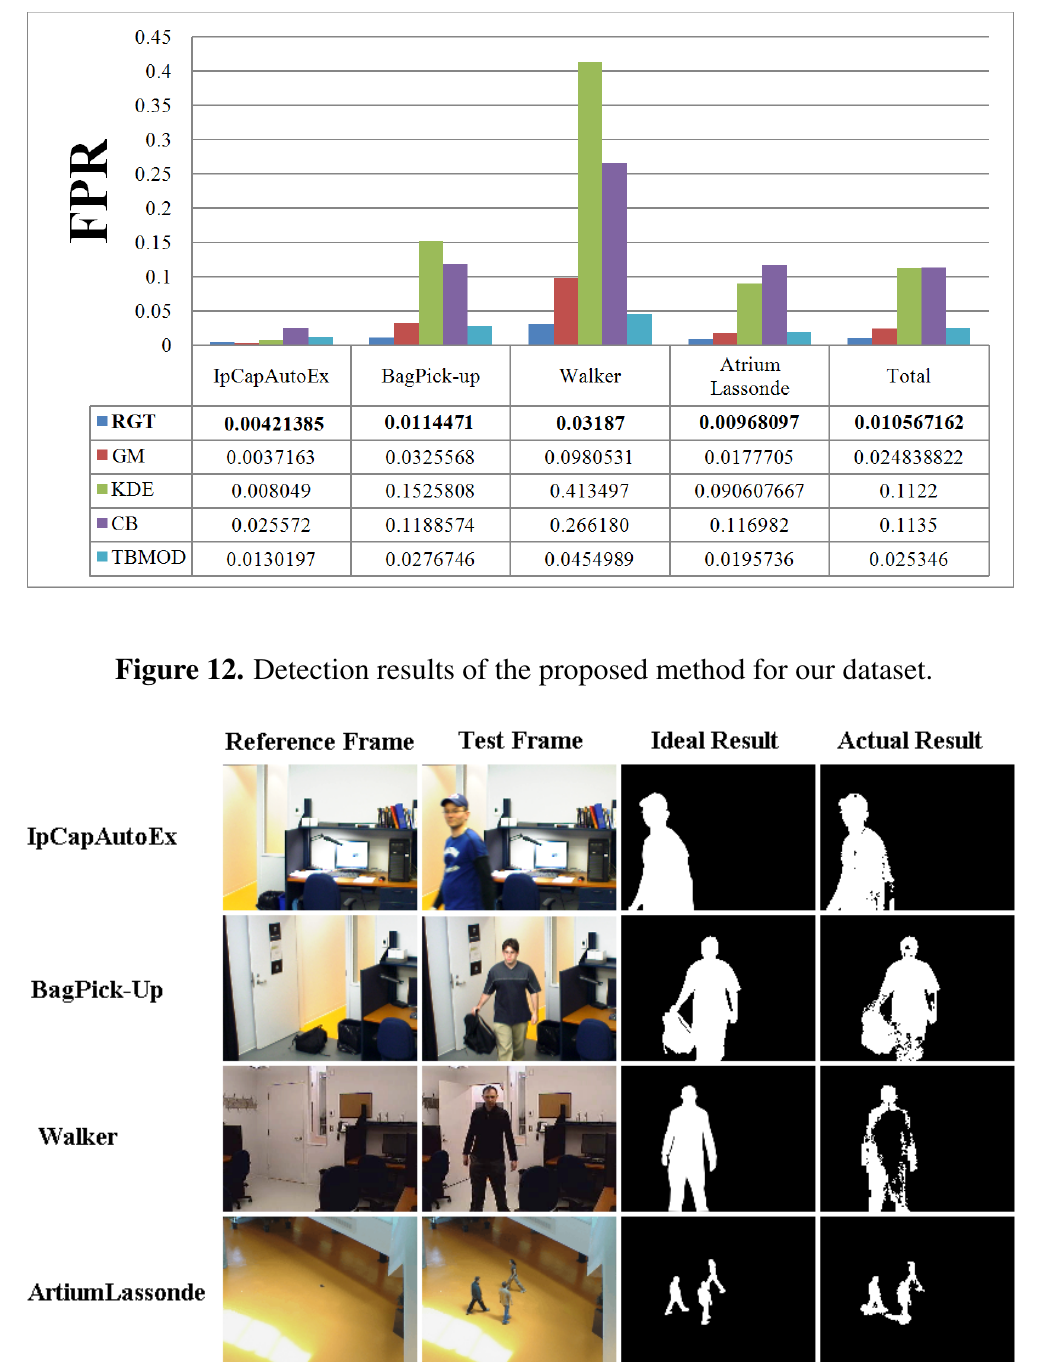
Figure 11. False Positive Rate of variations of the proposed background subtraction method for our dataset. The Total column is the combination of all videos. RGT: our method, GM: Gaussian Mixture, KDE: Kernel Density Estimation, CB: CodeBook, TBMOD: Texture-based Moving Object Detection.